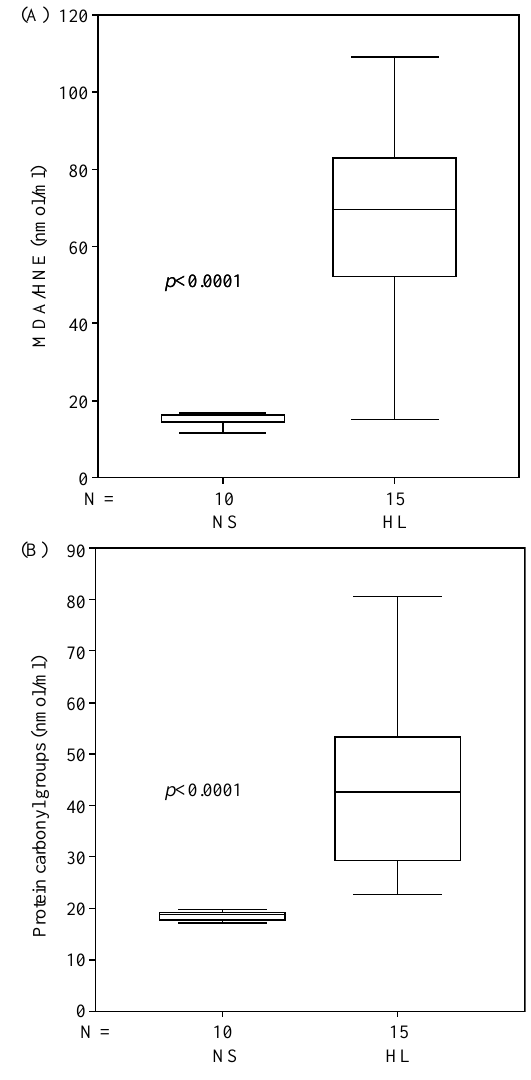
FIG. 1. Serum levels of (A) MDA/HNE and (B) protein carbonyl groups detected in normal subjects (NS) and patients affected by